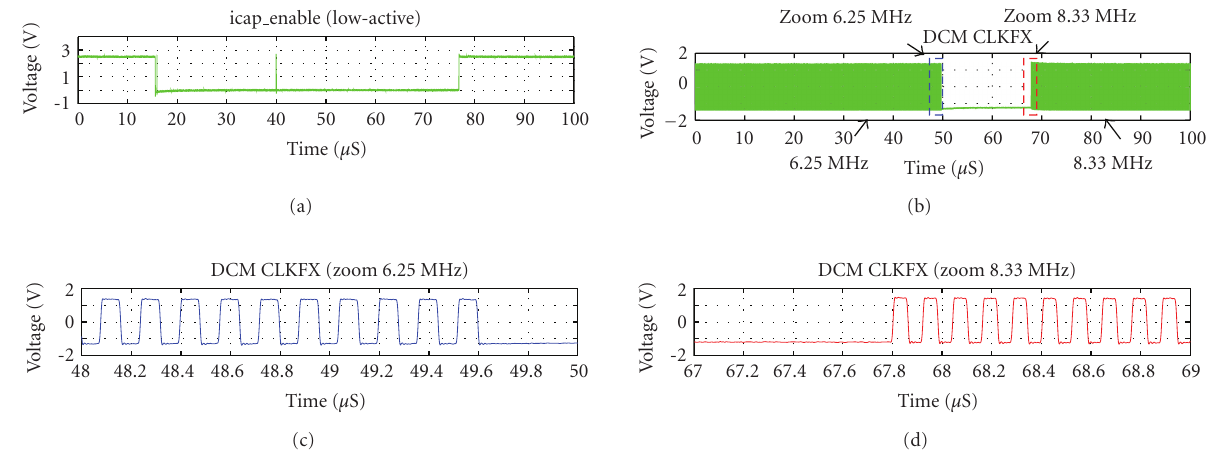
Figure 5: DCM reconfiguration performance: (a) ICAP enable, (b) DCM CLKFX output, (c) zoom of DCM CLKFX output before recon- figuration, and (d) zoom of DCM CLKFX output after reconfiguration.